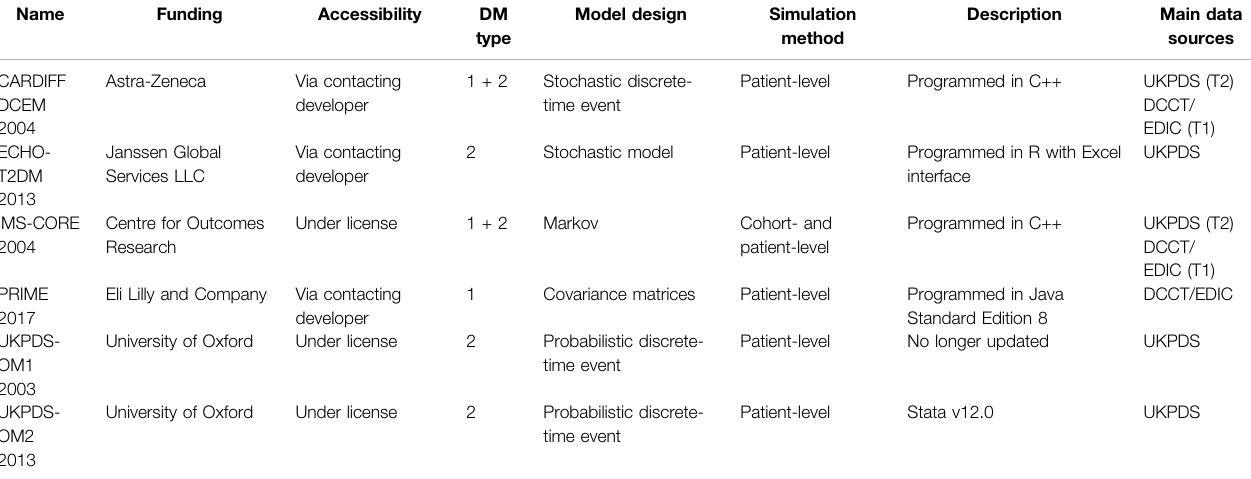
TABLE 2 | Description of the six main models employed in NICE ’ s TAs, including their date of conception, their source of funding and accessibility, the type of DM encompassed, their design and simulation method, the type of software supporting them, the main source of data for outcomes, utilities, and